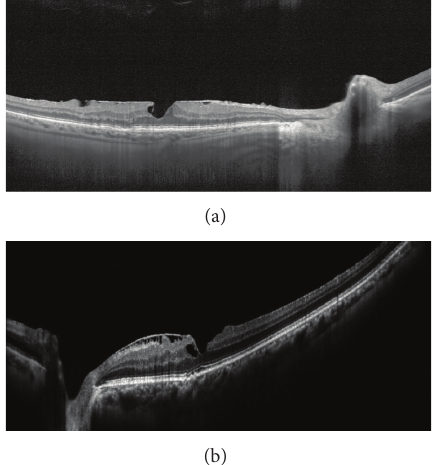
Figure 5: (a)-(b) VPA with pseudomacular hole